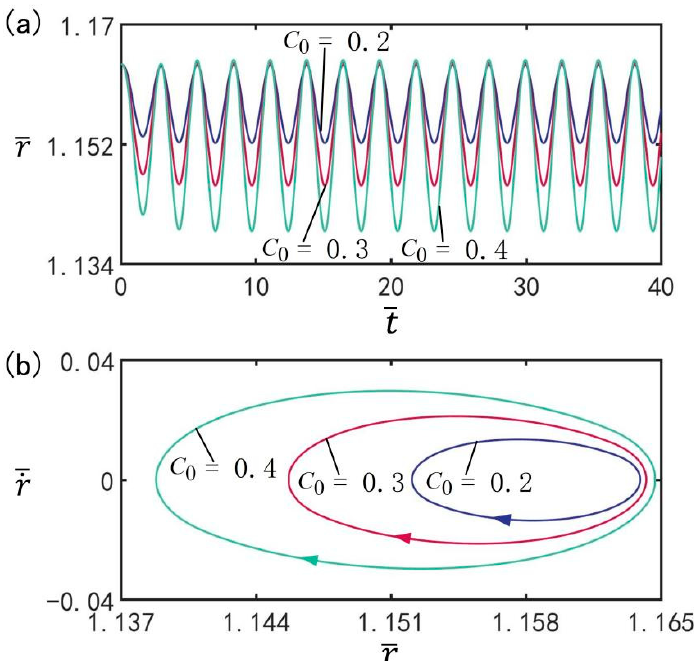
C on the beating of the LCE balloon. ( a ) Time 0